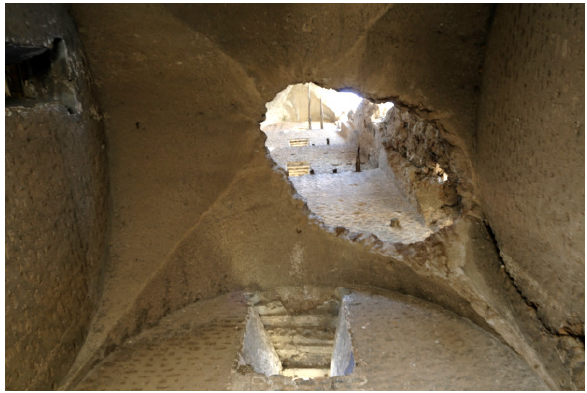
Figure 3.T. Maggiore crossed vault and middle wooden ceilings